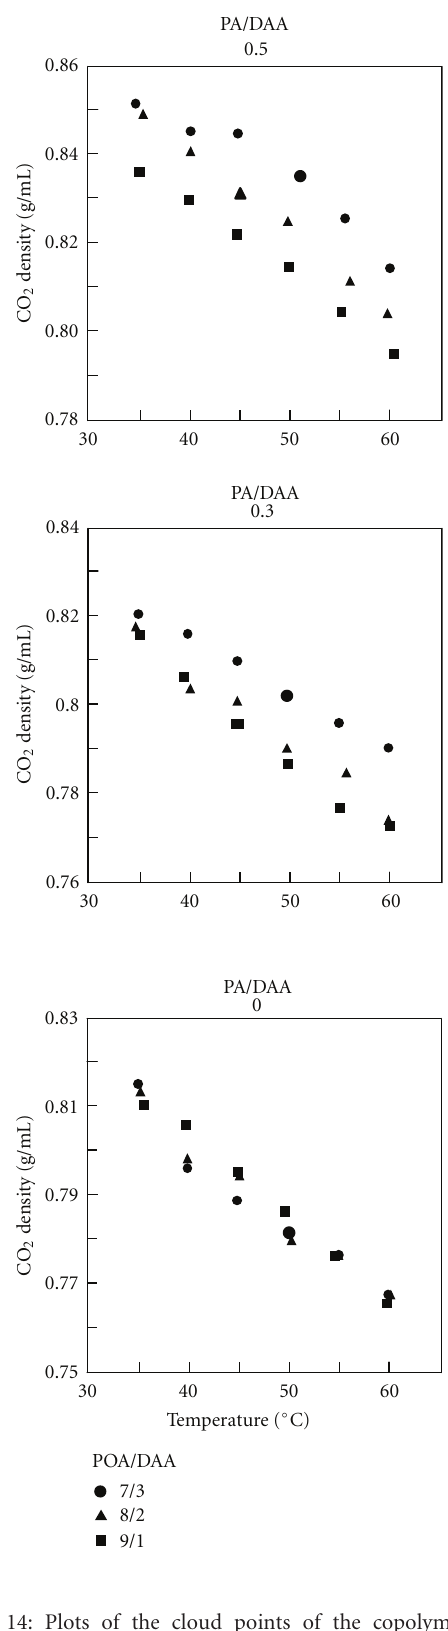
Figure 14: Plots of the cloud points of the copolymers with POA/DAA of 7/3, 8/2, and 9/1 in the absence and presence of PA at 0.3 and 0.5 of